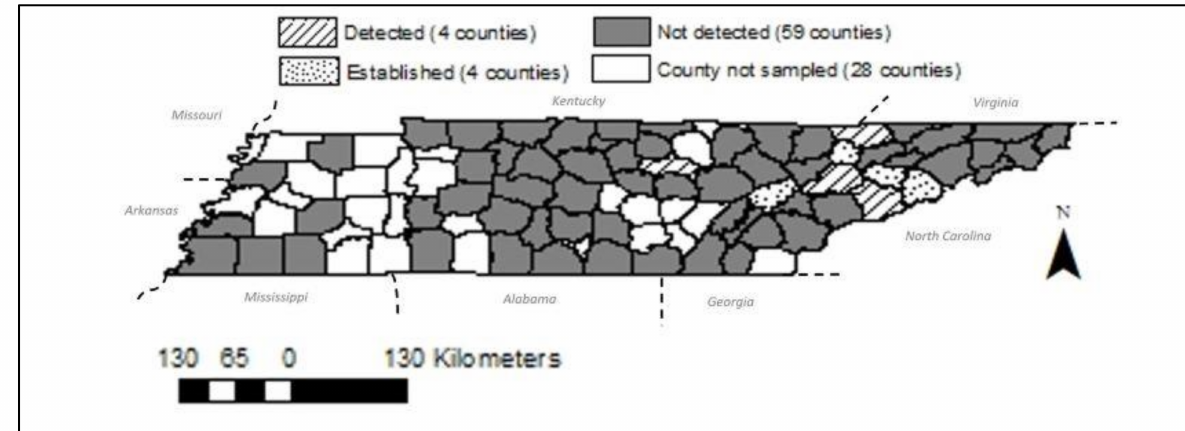
Figure 2. Known occurrence of Haemaphysalis longicornis in Tennessee, USA, as determined from samples submitted to the University of Tennessee by a cooperating statewide network of collectors, 2019–2020. We successfully reached 67 counties (gray) of the 95 counties in Tennessee and were able to identify established Haemaphysalis longicornis populations in Union, Roane, Jefferson, and Cocke Counties (dotted) and detect populations in Knox, Claiborne, Putnam, and Sevier Counties (striped) within this study